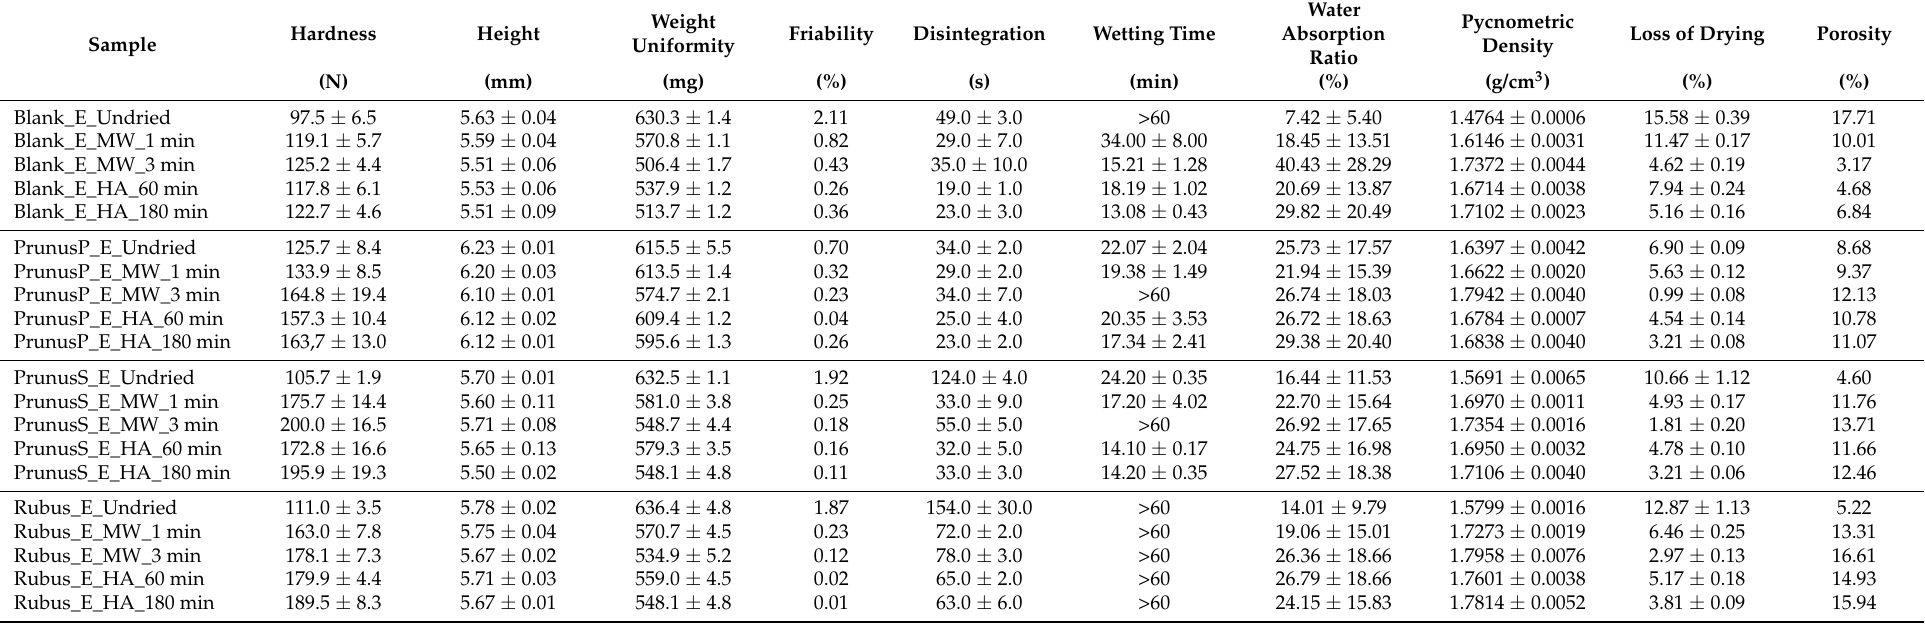
Table 5. Physico-mechanical evaluation of tablets with ethanolic plant